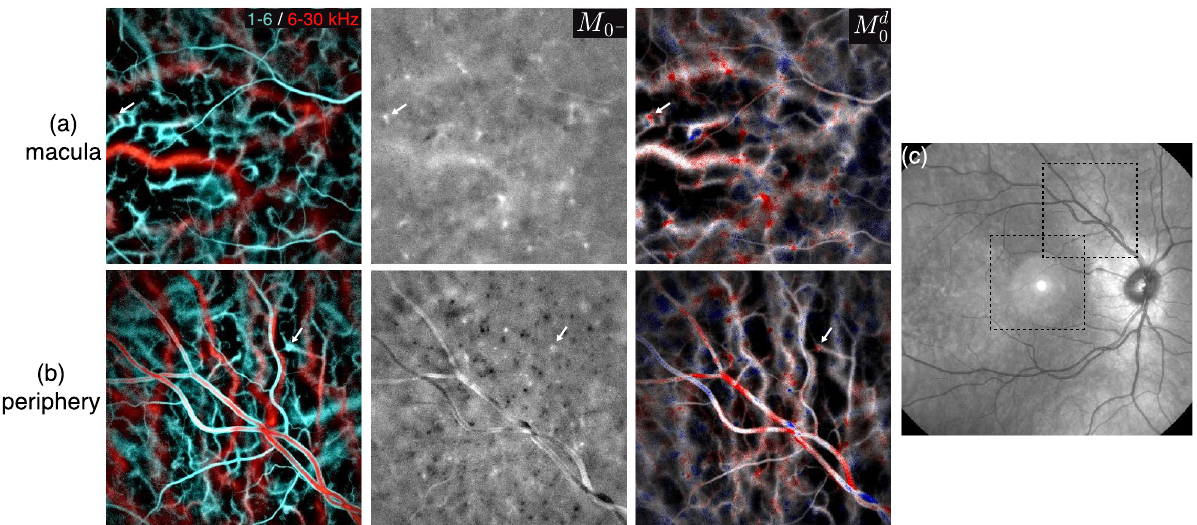
Figure 3. Directional contrast in choroidal structures. ( a , b ) In a macular and peripheral region, the slow/fast flow color composite images, the spectrum difference, and the directional power Doppler images are shown. The upright sections of the choroidal arterioles and venules (white and black dots) are better revealed in the peripheral region. ( c ) Scanning laser ophthalmoscope image showing the two